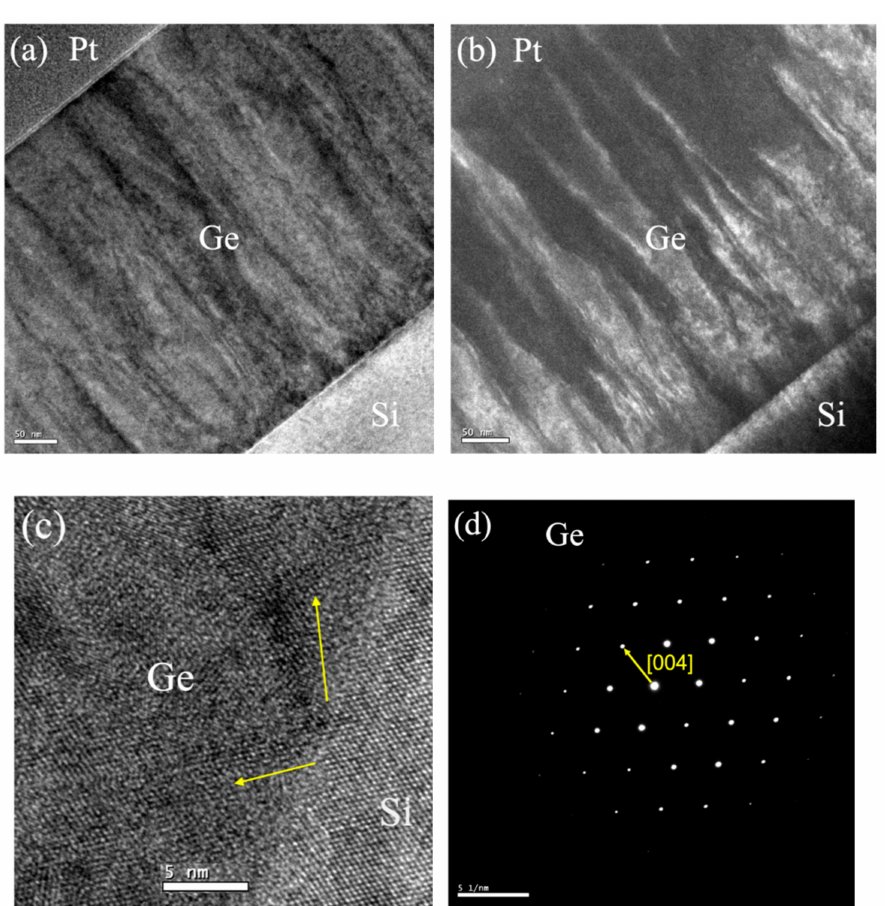
Figure 6. TEM: ( a ) cross-sectional bright-field image; ( b ) cross-sectional dark-field image; ( c ) Si substrate and Ge film image; ( d ) TEM electron diffraction diagram for RF sputtered Ge film grown with a sputtering power of 125 W, substrate bias of 100 V, and hydrogen flow of 0.8